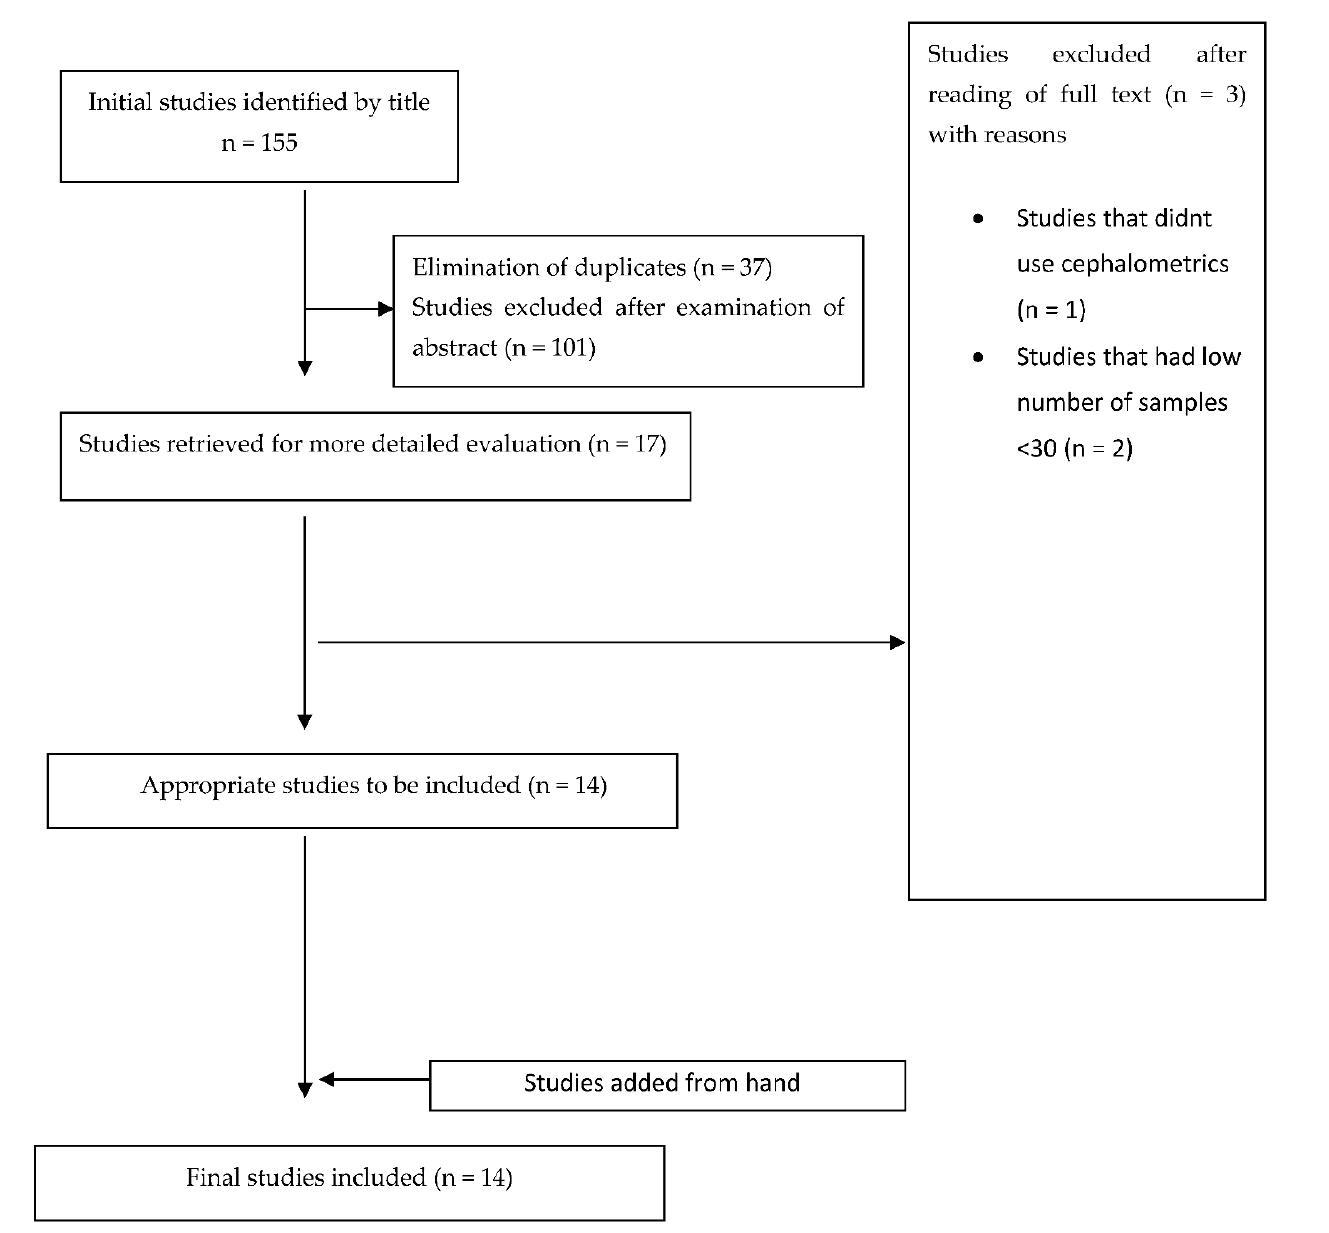
Figure 1. Flow diagram, selection of studies.